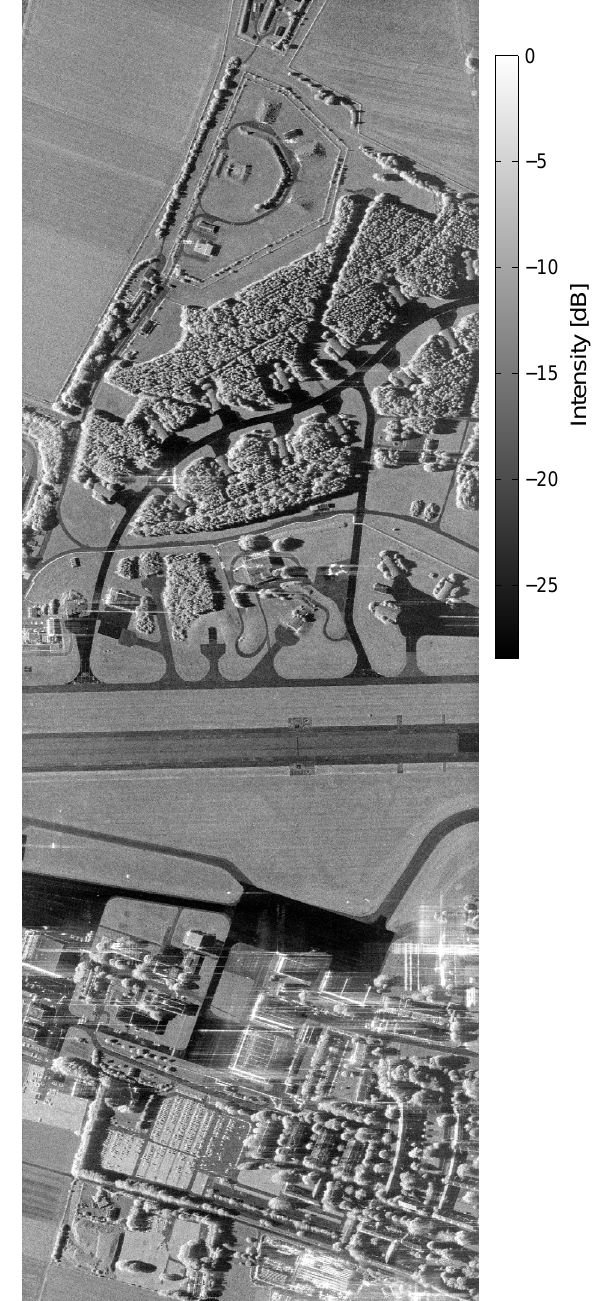
Figure 4. Intensity image of acquisition M4 in range-azimuth geometry. Azimuth and slant range extent: 2.1 x 0.6 km. Intensity scaled relatively: 28.4 dB black to